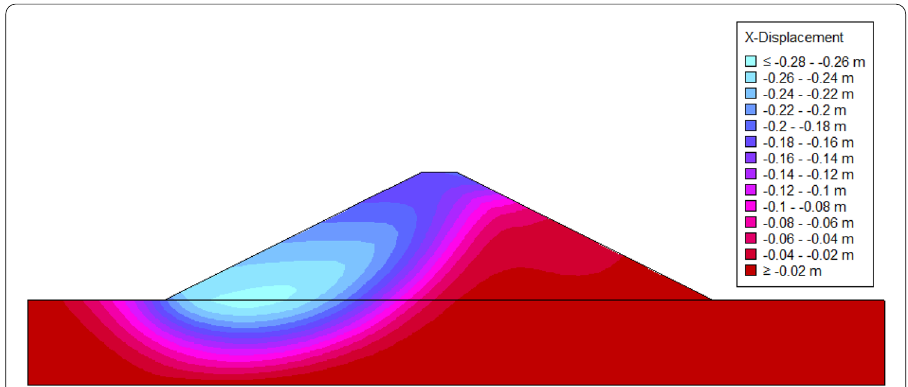
Fig. 21 Horizontal displacement contours within the earthen dam upon completion of reservoir drawdown on the 5th day